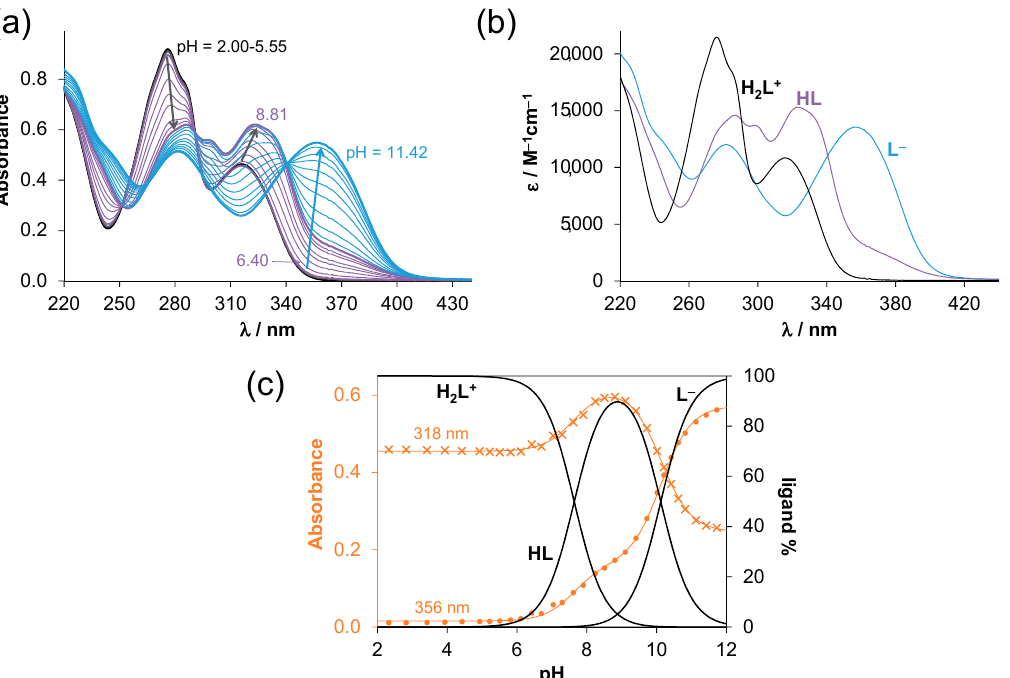
Figure 2. ( a ) UV-vis absorption spectra of SISC recorded at various pH values in water; and ( b ) individual molar absorbance spectra of the ligand species in the different protonation states; ( c ) Concentration distribution curves with absorbance values measured at 318 nm (×) and 356 nm ( ● ) with the fitted curves. ( c ligand = 42 µM; T = 25 °C; I = 0.10 M (KCl); ℓ = 1 cm). 1 H NMR spectra recorded for SISC in 30% ( v / v ) d 6 -DMSO/H 2 O (Figure S3) clearly